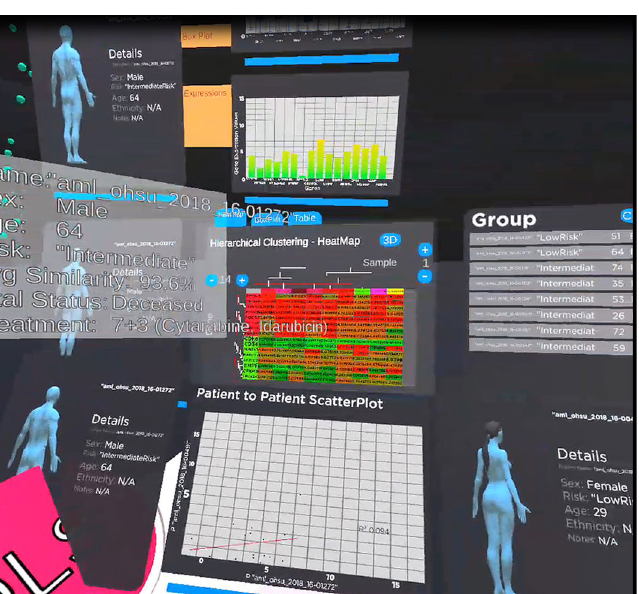
Figure 10. The analyst can stack all the panels anywhere in the immersive space to allow them to conduct a detailed analysis. This is possible in immersive space as there is unlimited space that can be